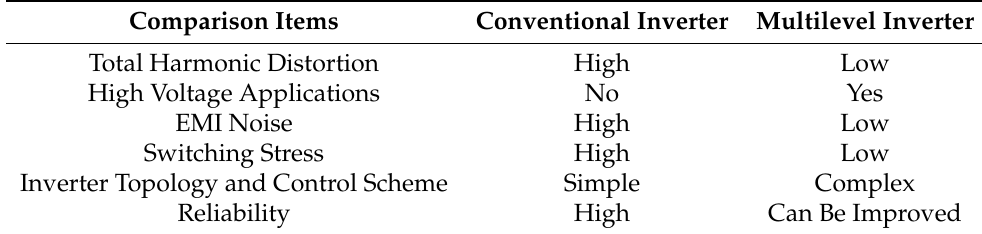
Table 1. Comparison between conventional and multilevel